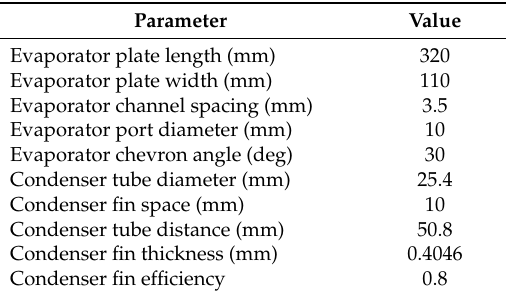
Table 1. Secondary loop evaporator and condenser key geometric